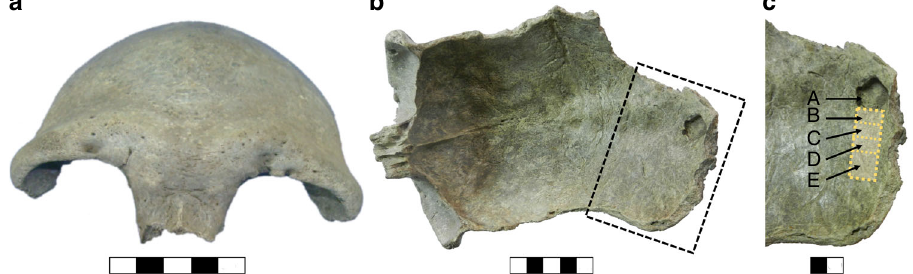
Fig. 2 The Salkhit skullcap. In norma frontalis (1), in norma basilaris showing the fi rst sampling for dating A (2) and the areas of sampling B, C, D and E (3) for genetic analyses and compound-speci fi c radiocarbon dating. Blocks on scale bars represent 1 cm